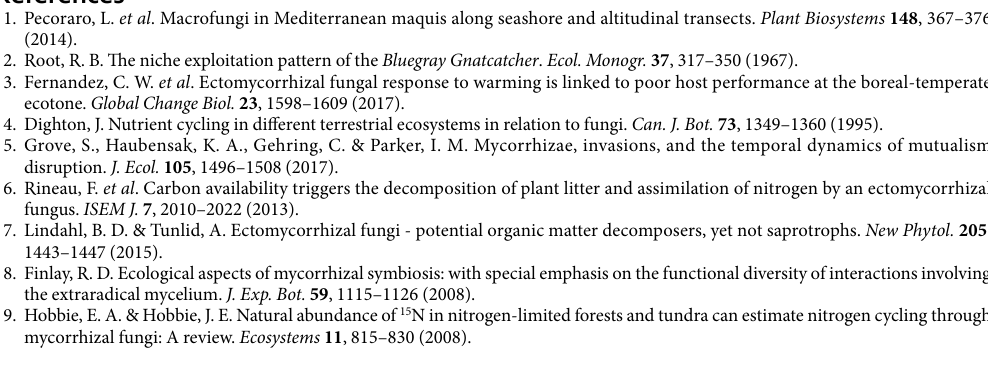
Isolation Kit (Sangon Biotech, China) according to the manufacturer’s instructions. The universal primers ITS1: 5 ′ -TCCGTAGGTGAACCTGCGG-3 ′ and ITS4: 5 ′ -TCCTCCGCTTATTGATATGC-3 ′ were employed to identify fungal taxa 52 . DNA extraction of endophytic bacteria and Illumina sequencing. Total bacterial DNA was extracted using a FastDNA ® Spin Kit for soils (MP Biomedicals, USA) according to the manufacturer’s instruc- tions. Extracted DNA was diluted to 1 ng/ μ L with sterile deionised water according to the concentration. Primers Bakt_341F (5 ′ -CCTACGGGNGGCWGCAG-3 ′ ) and Bakt_805R (5 ′ -GACTACHVGGGTATCTAATCC-3 ′ ) 52 (N = any base, W = A/T, H = A/C/T, and V = A/C/G) were used to amplify the V3-V4 region of the 16 S rDNA. Barcodes were added to the forward and reverse primers to attribute sequences to each sample. The program for V3-V4 region amplification was set so as to impose the following conditions: a lid temperature of 105 °C; initial denaturation for 30 s at 98 °C; annealing and Taq operation cycle repeated 30 times at 98 °C for 15 s, 58 °C for 15 s, and 72 °C for 1 min; followed by the final lengthening process at 72 °C for 1 min. All PCR reactions were performed with Phusion ® High-Fidelity PCR Master Mix. Agencourt AMPure XP 60 ml Kit (Beckman Coulter, USA) was used to purify PCR products. The purified PCR products were detected by Nanodrop (THERMO, USA) apparatus, to evaluate the quality of DNA. Then according to the concentration, target PCR products were mixed at an equimolar ratio and electrophoresed on 2% agarose gel and extracted using an AxyPrep ™ DNA Gel Extraction Kit (AXYGEN SCIENTIFIC, USA). Sequencing libraries were quantifies using Library Quant Kit Illumina GA revised primer-SYBR Fast Universal kit according to the manufacturer’s recommendations. The library quality was assessed using the Qubit dsDNA HS Assay Kit (THERMO, USA) and Agilent Bioanalyzer 2100 system (AGILENT TECHNOLOGIES, USA). Finally, the library was sequenced on an Illumina Miseq plat- form by the Guhe Information Technology Co., Ltd, Hangzhou, China. The whole metagenomics dataset was submitted to Sequence Read Archive (SRA) of NCBI and the SRA accession is SRP128958. Data processing and statistical analyses. Raw sequencing data generated by Illumina were separated by samples according to barcode sequences. Raw reads were merged into a complete sequence in FLASH as supposed from valid reads 53 . The primer of the merged reads was moved by cutadapt 54 . Then, the high-quality clean reads thus obtained were used for OTU clustering by simultaneously removing singleton reads by using Uparse. Representative reads with the highest abundance in each OTU were selected for annotating information with SILVA 55 by using the UCLUST algorithm 56 in QIIME at 97% similarity. Finally, to ensure fair comparison between samples, all samples were normalised to the minimum number of effective reads and the normalised data were used for downstream analyses. Rarefaction curves and α -diversity indices of Chao1, Shannon, and Simpson were produced in QIIME. For β -diversity, an OTU level-based dissimilarity weighted_unifrac metric was used to measure the pair-wise community similarity between samples, and principal component analysis was used to visualise the distance matrix of all 36 samples in QIIME. A T -test was performed in SPSS 20 (IBM, USA).